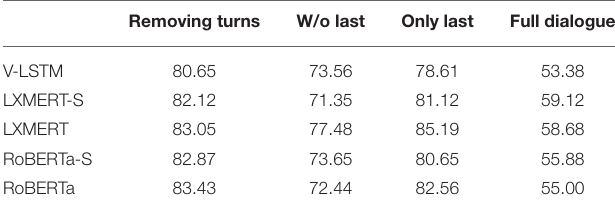
TABLE 9 | Error Analysis: Percentage of games human failed among those failed by each model. Removing turns